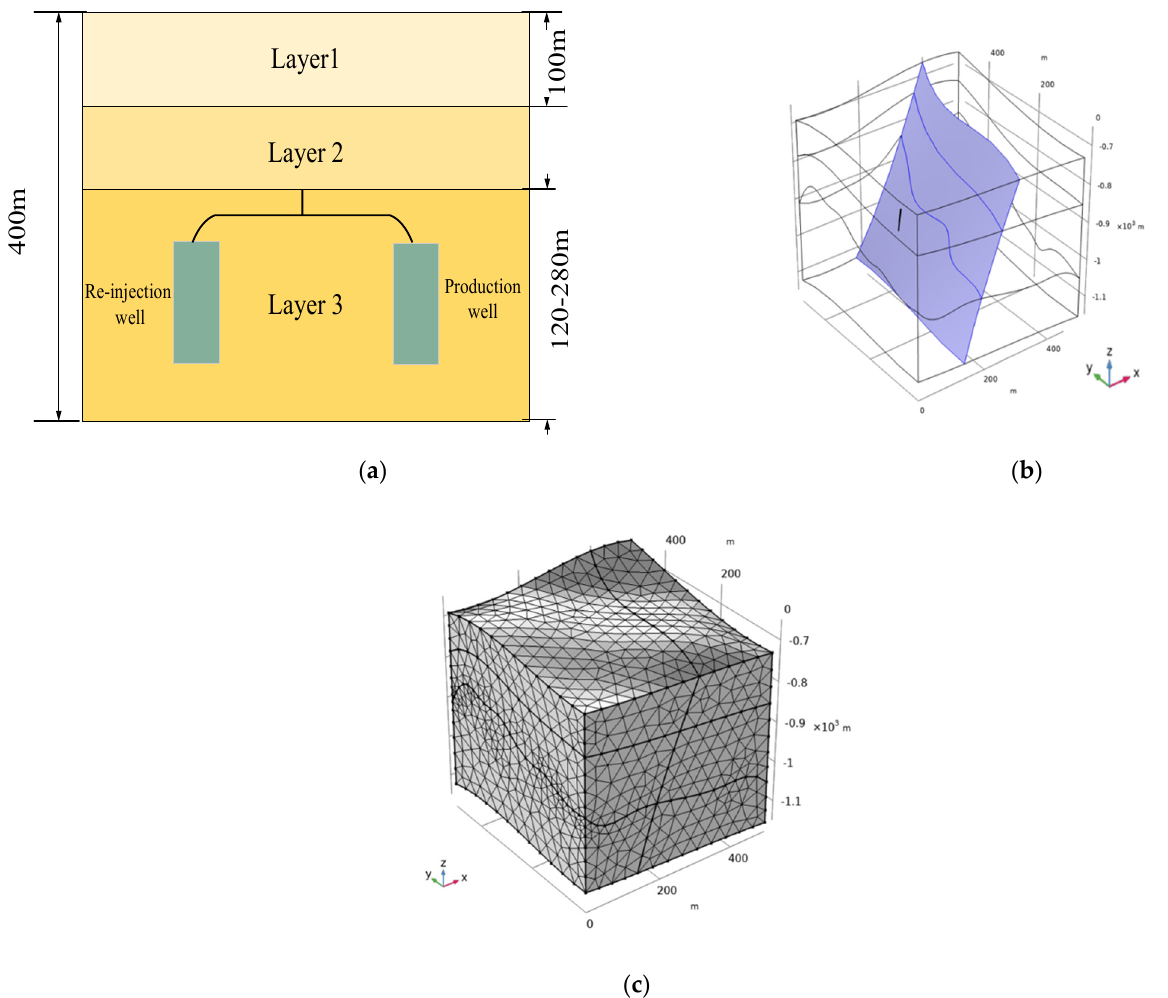
Figure 1. ( a ) The geothermal model with three geologic layers; ( b ) fracture, and the doublet’s production; ( c ) the generated computational grid.